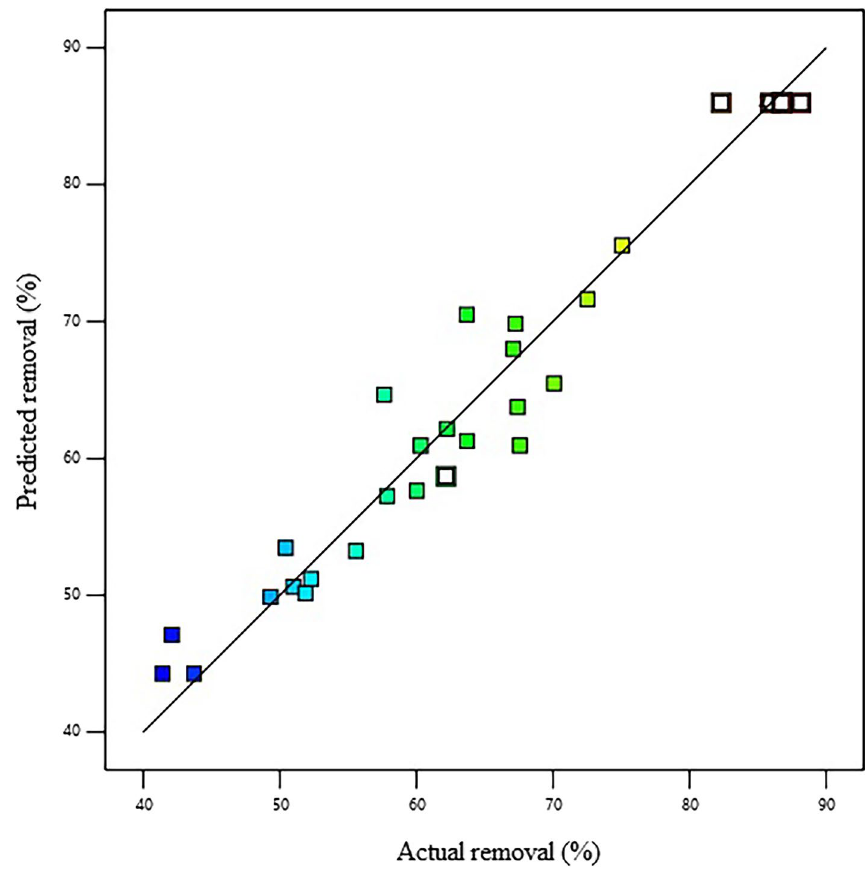
Fig. 4 Distribution of experi- mental versus predicted removal for MNZ biosorption onto S. platensis